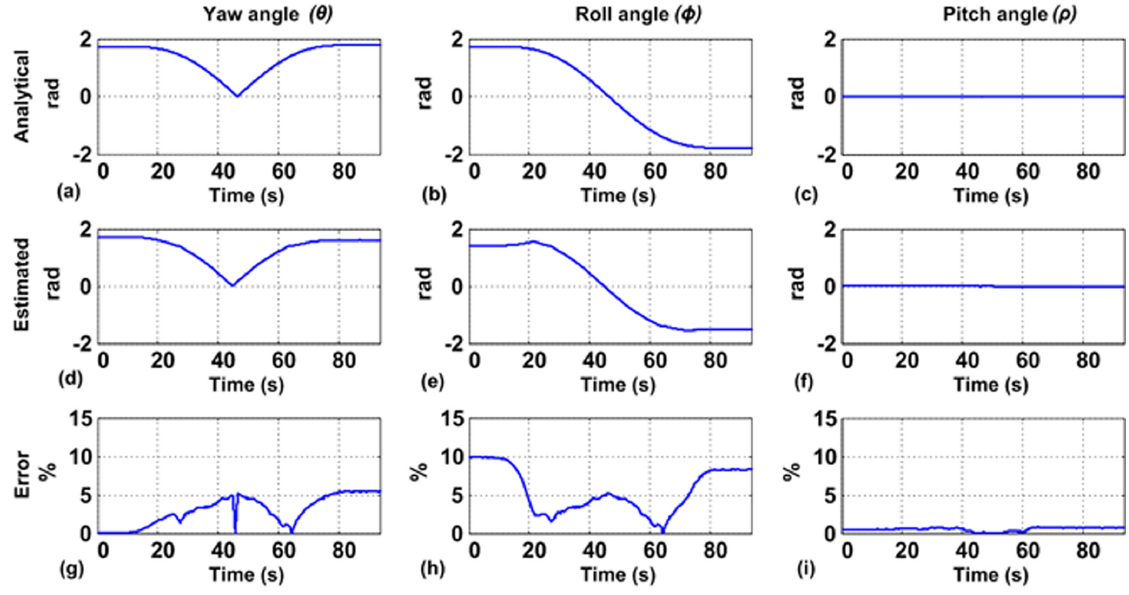
Figure 10. Inclination estimated results: (a) analytical yaw, (b) analytical roll, (c) analytical pitch, (d) estimated yaw, (e) estimated roll, (f) estimated pitch, (g) yaw relative error (h) roll relative error, and (i) pitch relative